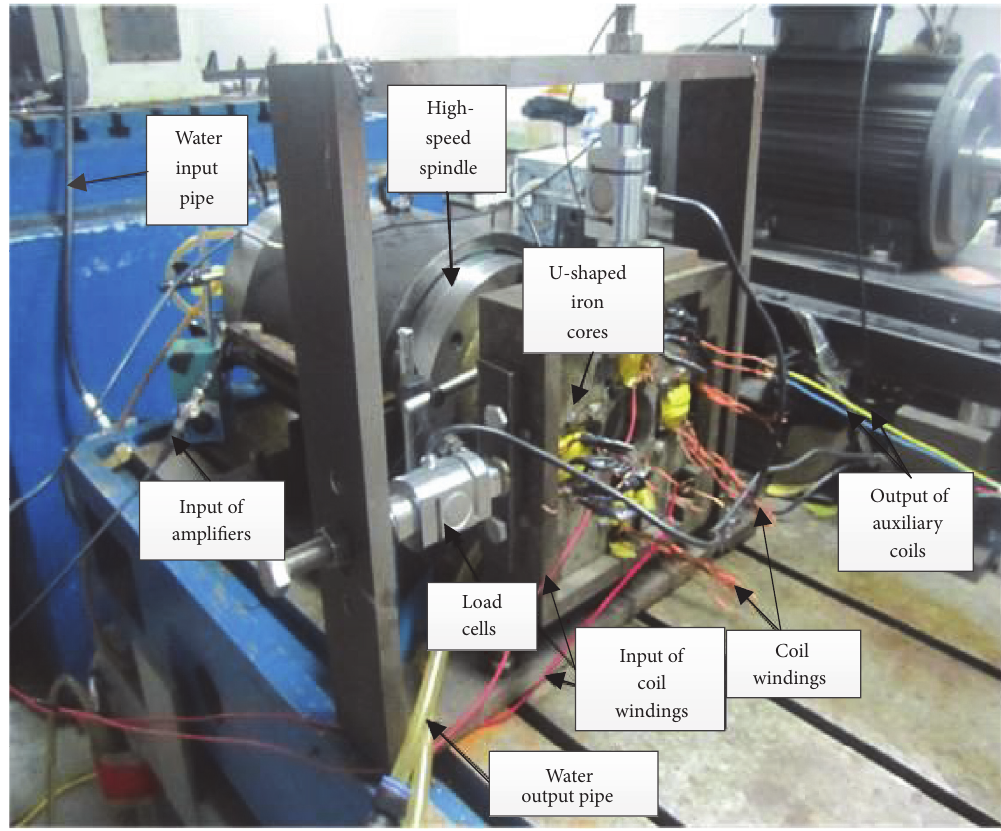
Figure 3: Schematic of the test rig for identifying dynamic